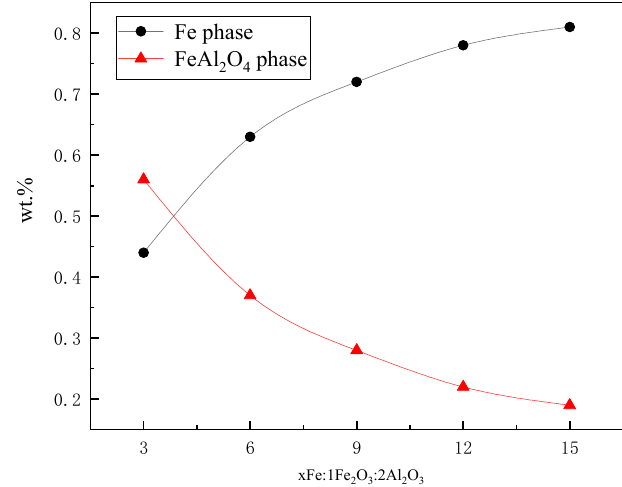
Figure 3. Mass fraction of phases in composites.